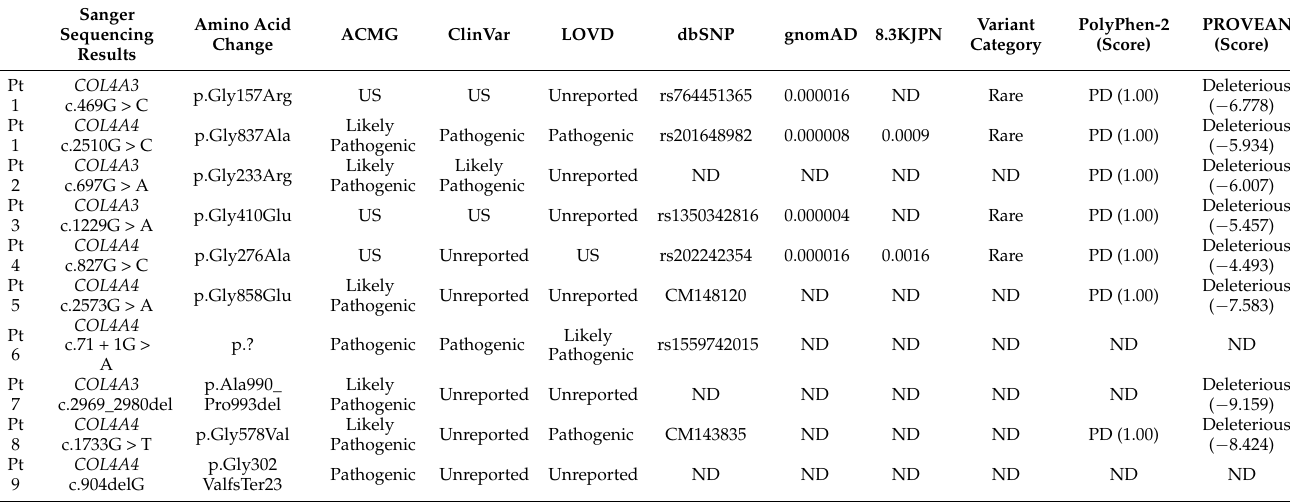
Table 2. Summary of the mutation